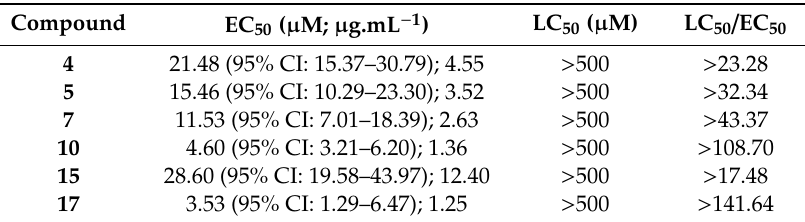
Figure 2. Dose-response of anti-settlement activity of the promising antifouling compounds 4 , 5 , 7 , 10 , 15 , and 17 toward plantigrades of the mussel M. galloprovincialis. B: negative control; C: CuSO 4 5 µ M as positive control. Table 1. Antifouling e ff ectiveness versus toxicity of compounds toward the anti-settlement of mussel plantigrades.